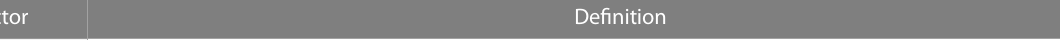
TABLE 1 Individual Sectors de fi